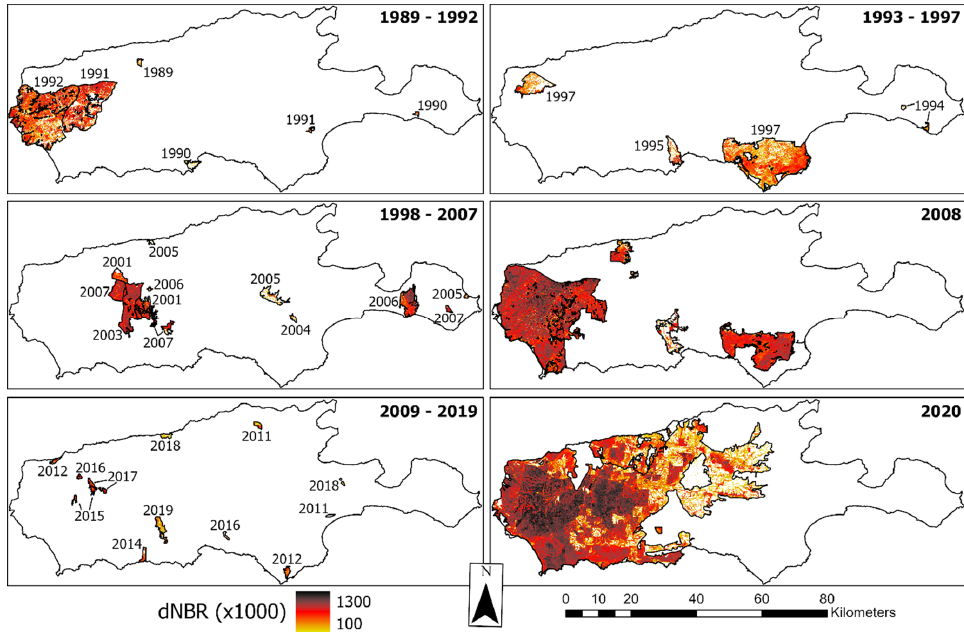
Figure 7. Burn severity (dNBR) for all recorded fires (>1 km 2 ) during the Landsat record (1988–1989 to 2019–20). Split into six periods to reduce overlap in multi-burn areas and highlight differences in burn extent through time. See Figure A2 for violin plot distributions of burn severity for each fire. See Figure A3 for a closer view of two smaller fires.